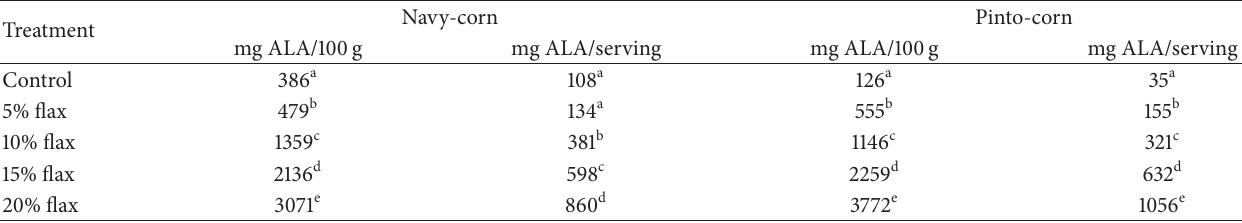
Table 4: 𝛼 -Linolenic acid (ALA) in the bean-corn extrudates.